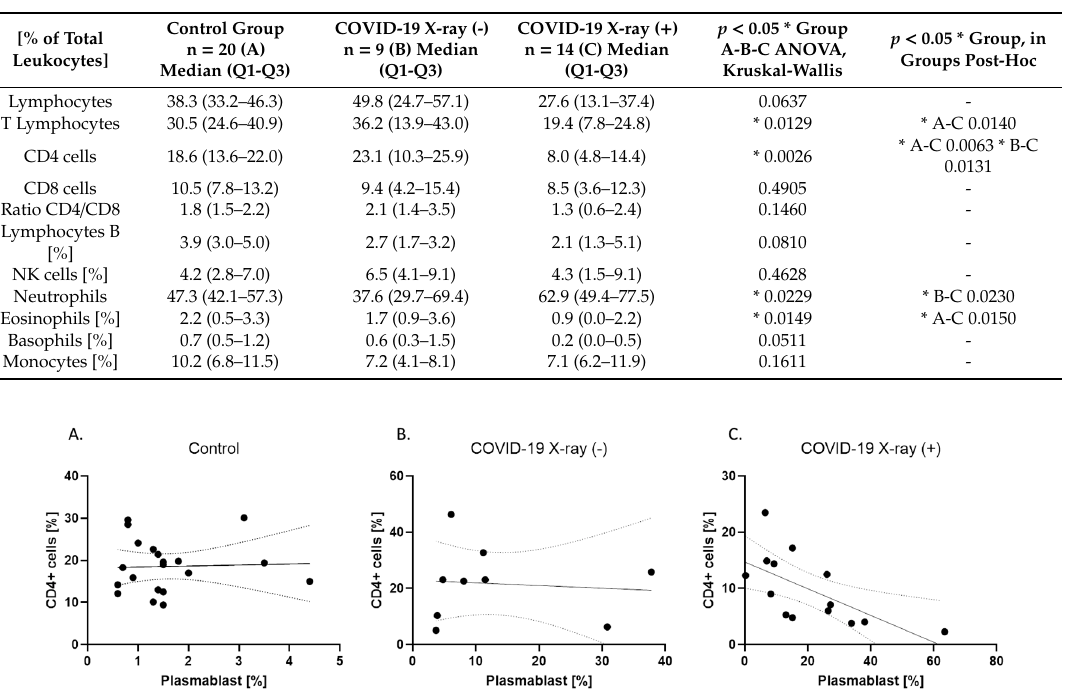
Table A1. Di ff erences in the median of leukocytes subpopulation percentages between healthy patients ( A ), patients with COVID-19 without interstitial lesions on chest X-ray (( B ): COVID-19 X-ray ( − )) and patients with COVID-19 with interstitial lesions on chest X-ray (( C ): COVID-19 X-ray ( + )). Data expressed as median (Q1–Q3).